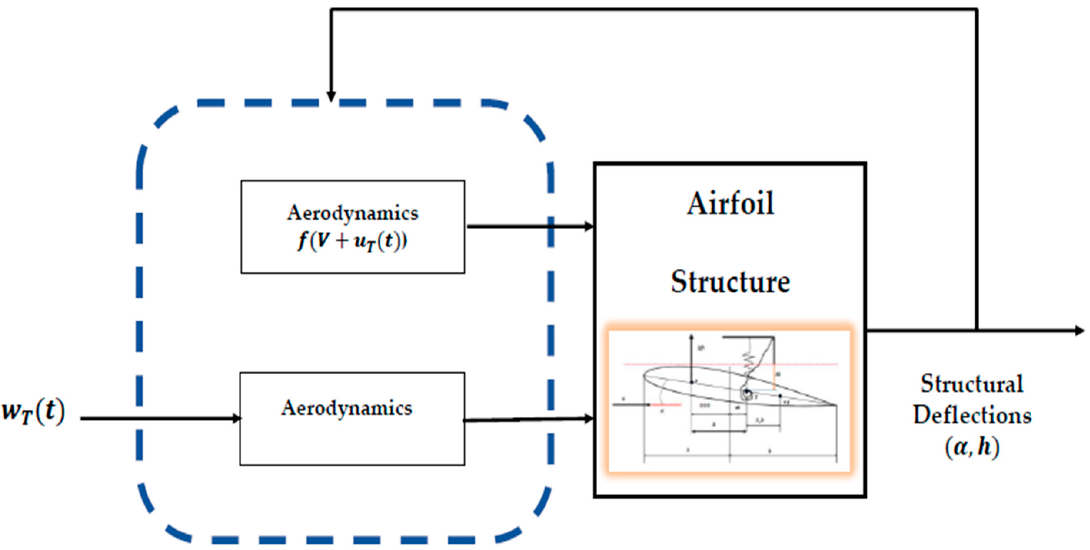
Figure 27. Aeroelasticity–turbulence interaction schematic.